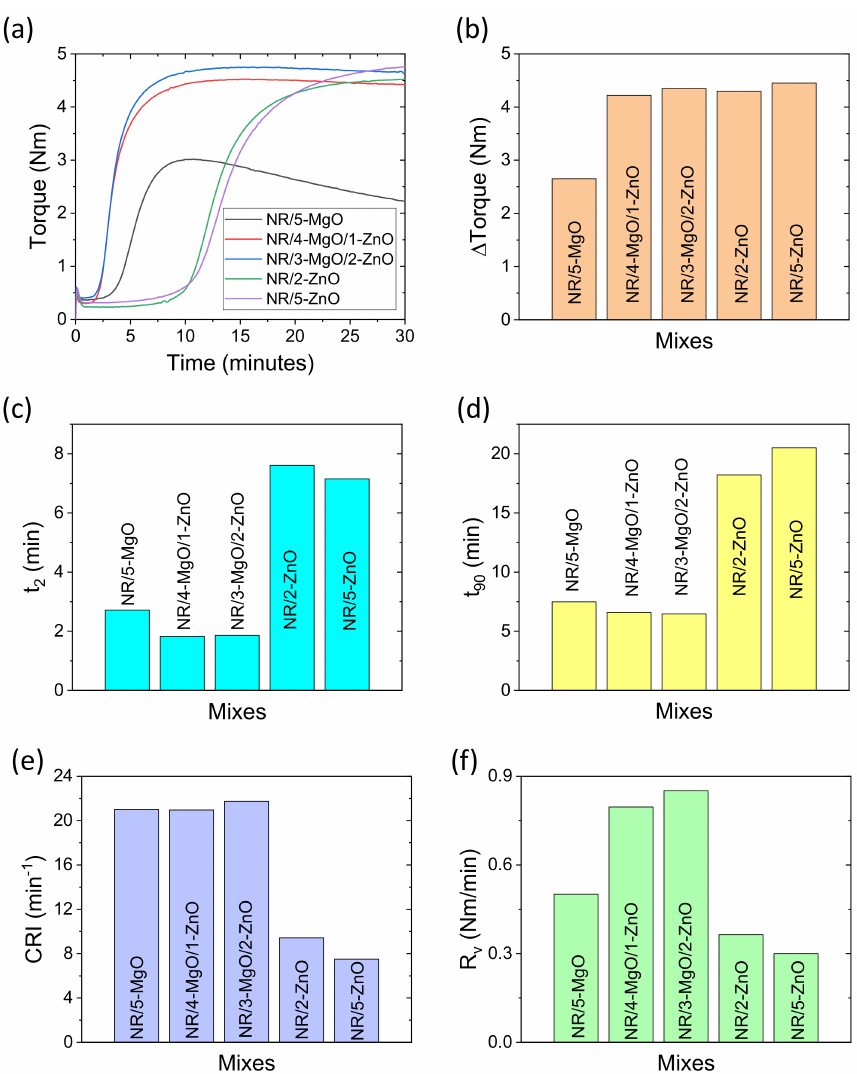
Figure 2. Curing characteristics of rubber vulcanizates; ( a ) rheographs, ( b ) ∆ torque, ( c ) t 2 , ( d ) t 90 , ( e ) CRI, and ( f ) R v